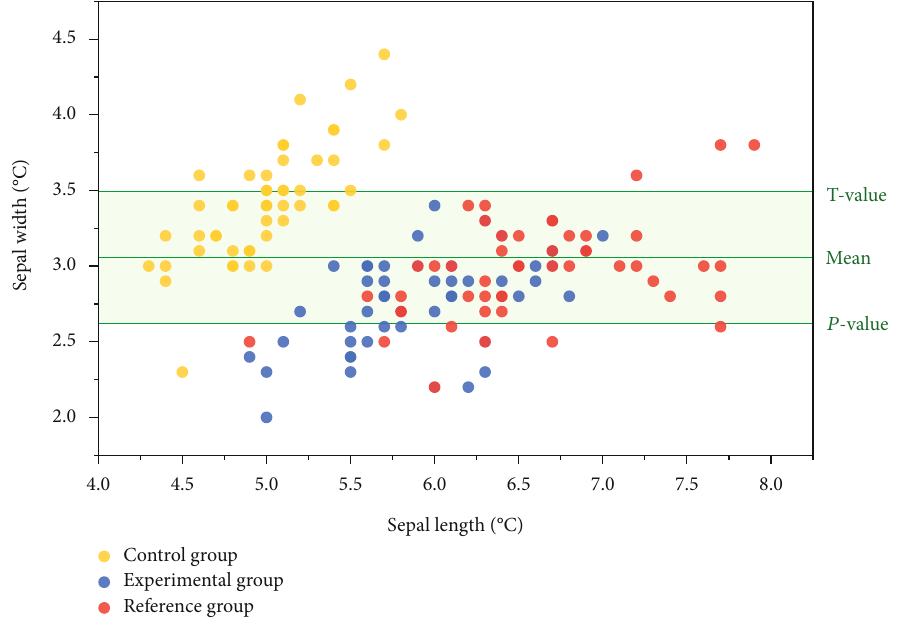
Figure 3: Comparison of the temperature di ff erence between the two groups of dashi